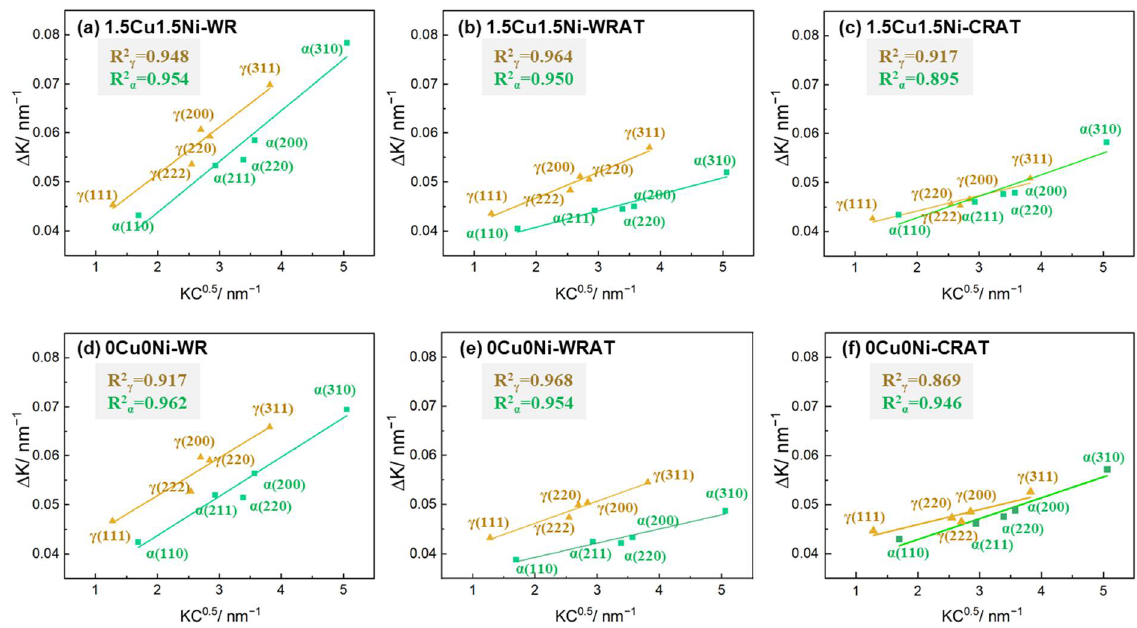
Figure 7. Linear fit analysis of the data points obtained from SYXRD peaks, which was utilized to estimate the dislocation density ( a – c ) for 1.5Cu1.5Ni and ( d – f ) 0Cu0Ni specimens.